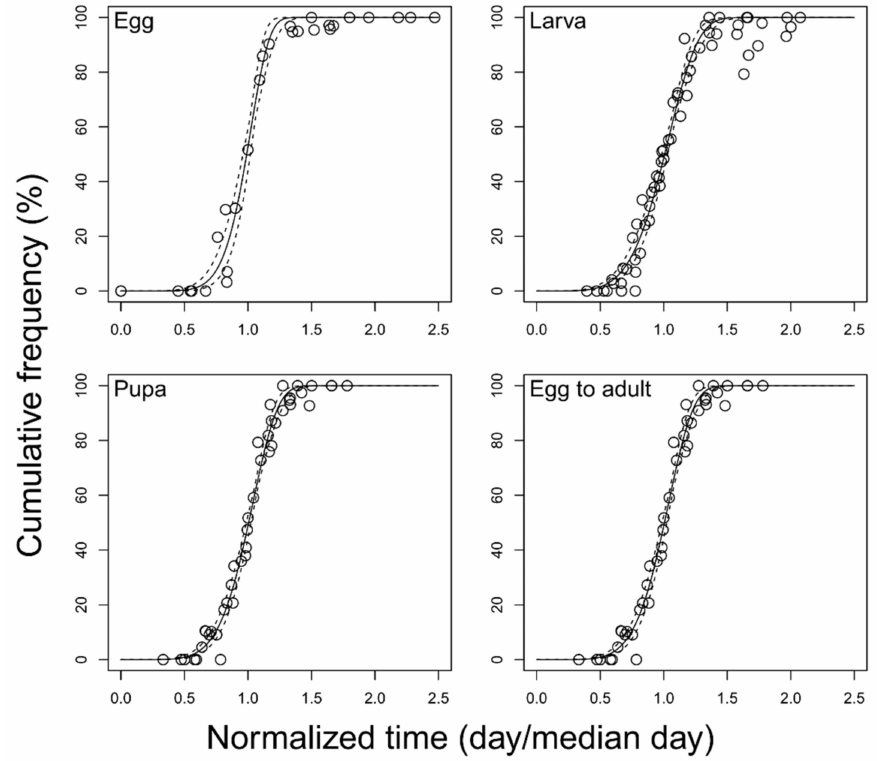
Figure 4. Cumulative distribution model for the frequency of development completion of Feltiella acarisuga . Estimated lines (solid lines) and 95% confidence interval (dashed